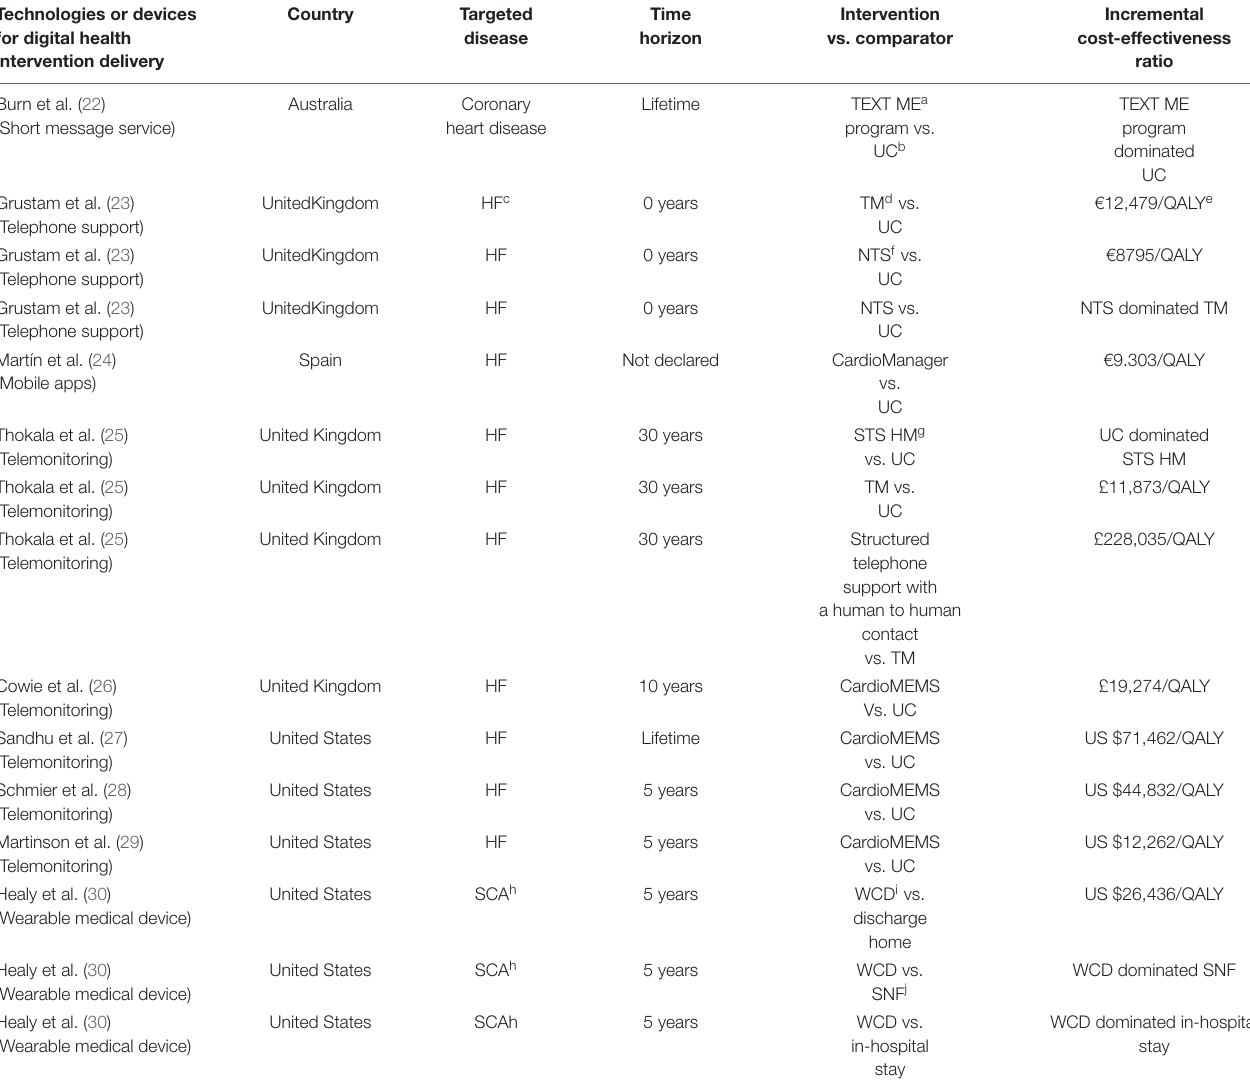
TABLE 1 | Comparison of different telemedicine cost effectiveness studies from Jiang et al.